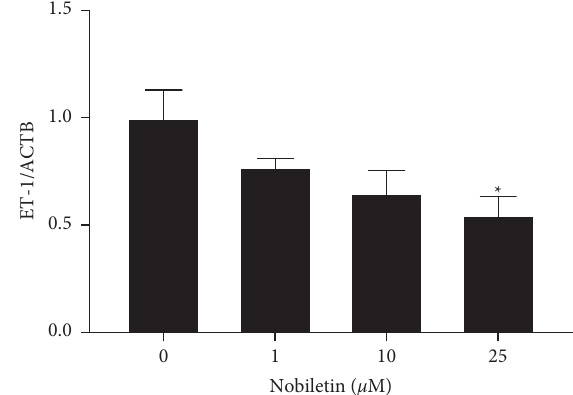
Figure 5: Effect of nobiletin (0–25 μ M) on ET-1 mRNA levels after 18h incubation. Data are presented as mean ± SD. ∗ indicates significant differences between the treatment group and untreated control group at p < 0 .